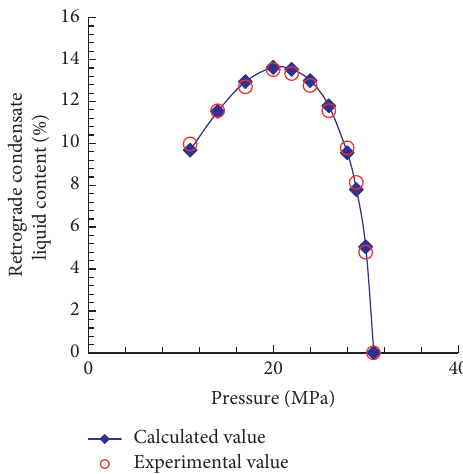
Figure 7: Comparison for sample 1 of calculated and experimental relationship diagram between retrograde condensate liquid volume and pressure.